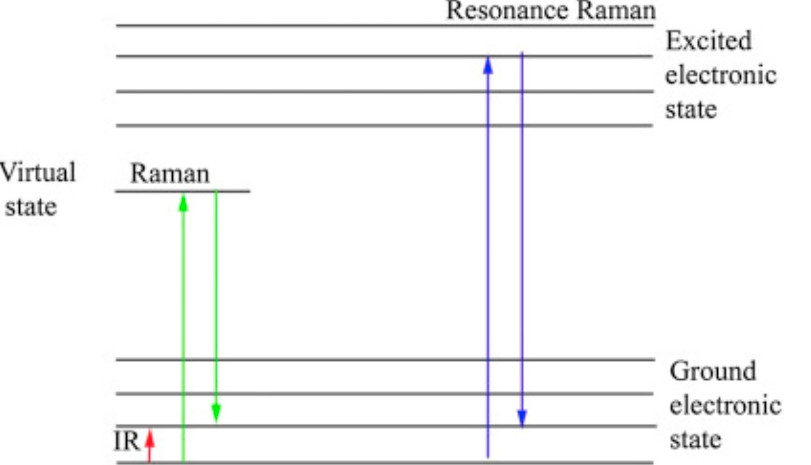
Figure 3. Schematic depiction of non-resonant and resonant Raman scattering processes. Energy levels are represented by horizontal lines, and the vertical arrows show the transition from one state to another (Reprinted with permission from [85]. 2022, Elsevier).